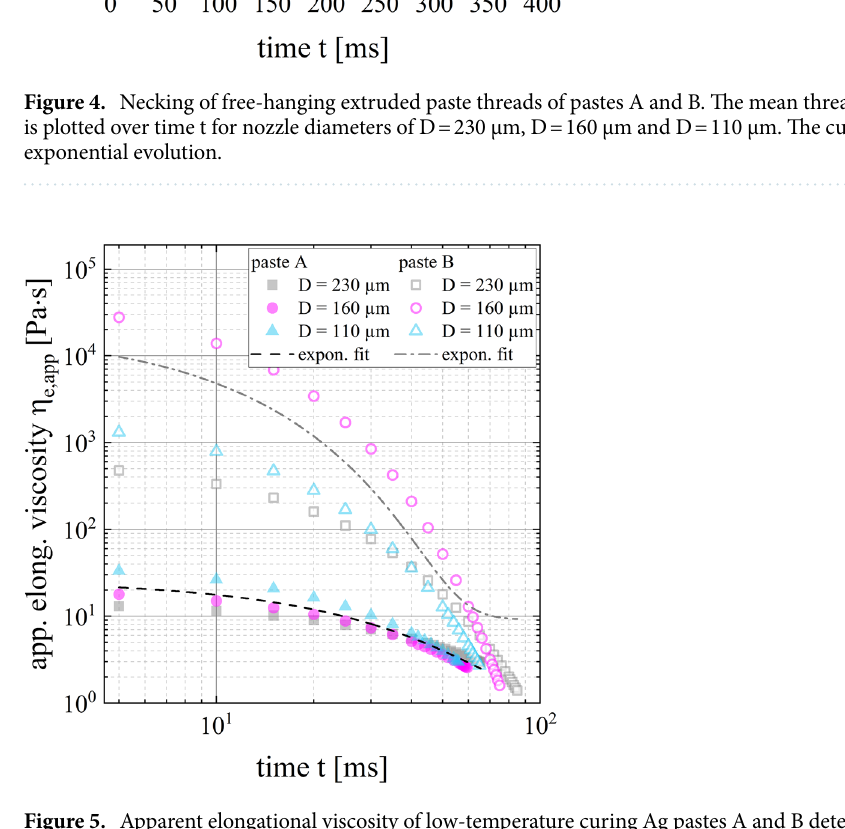
Figure 5. Apparent elongational viscosity of low-temperature curing Ag pastes A and B determined by filament necking at T = 25 °C. The elongational viscosity η e,app is plotted as a function of time